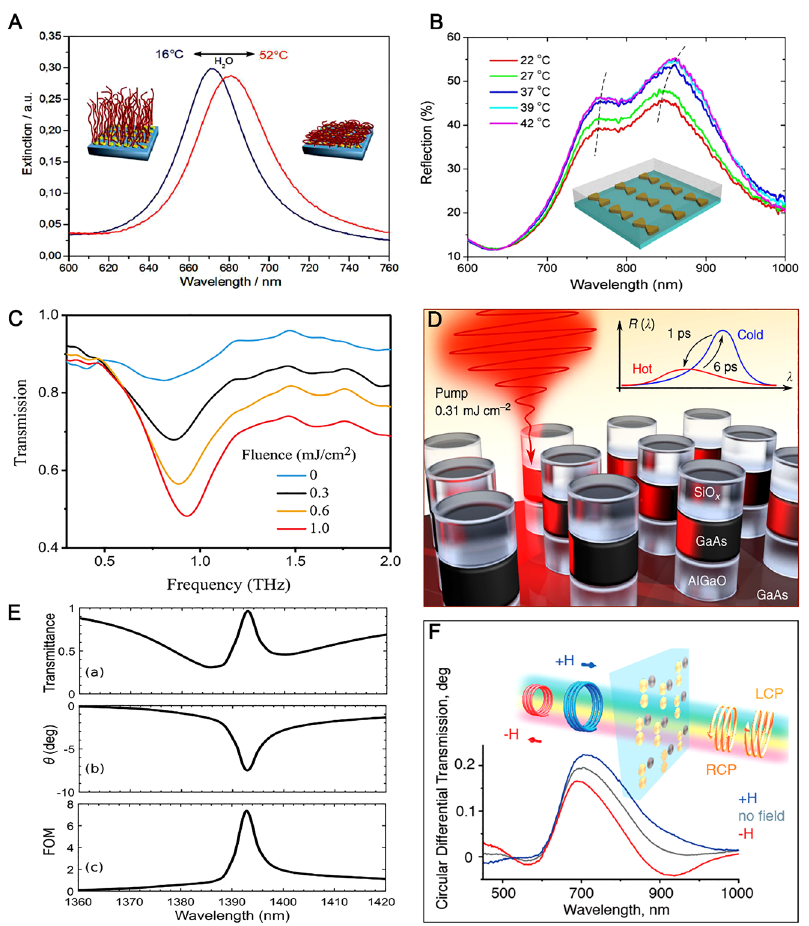
Figure 3: Tunable metasurfaces